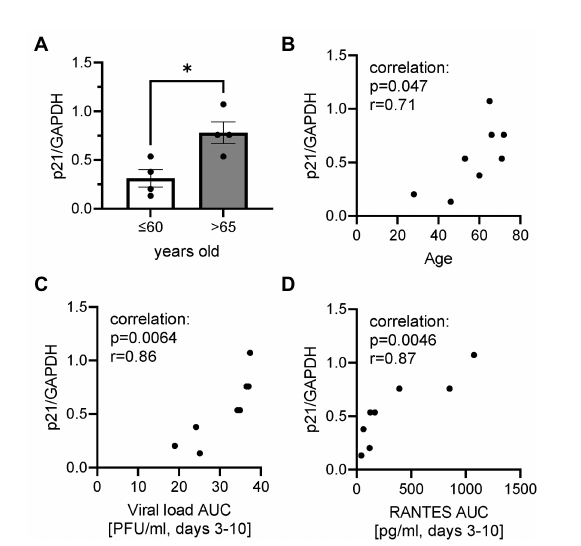
FIGURE 4 Basal p21 gene expression normalized by housekeeping gene GAPDH. (A) The comparison of basal p21 gene expression in cells collected from ALI-bronchial epithelium in younger ( ≤ 60 years old) and elderly (>65 years old) groups. A correlation between p21 gene expression and age (B) , plaque assay-viral load (Log, PFU/ml) AUC (C), or RANTES AUC (D) . * p <